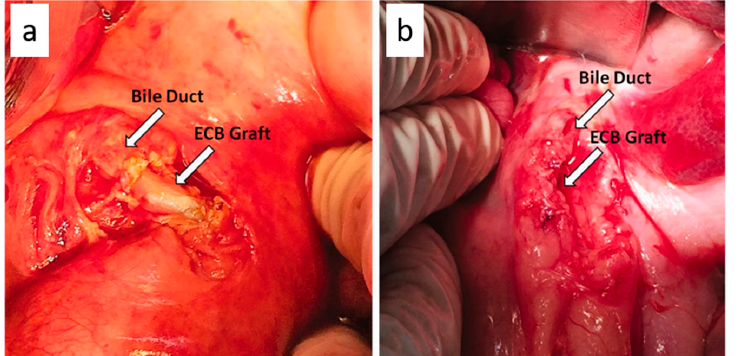
Figure 10. Longitudinal incisions on the anterior wall of the common bile duct and implanted cellulosic exopolysaccharide biopolymer (ECB); a BC film. The appearance of implanted BC films reoperated after 330 days ( a ) and 150 days ( b ). Reprinted with permission from reference [178], copyright © 2020, SAGE publication.